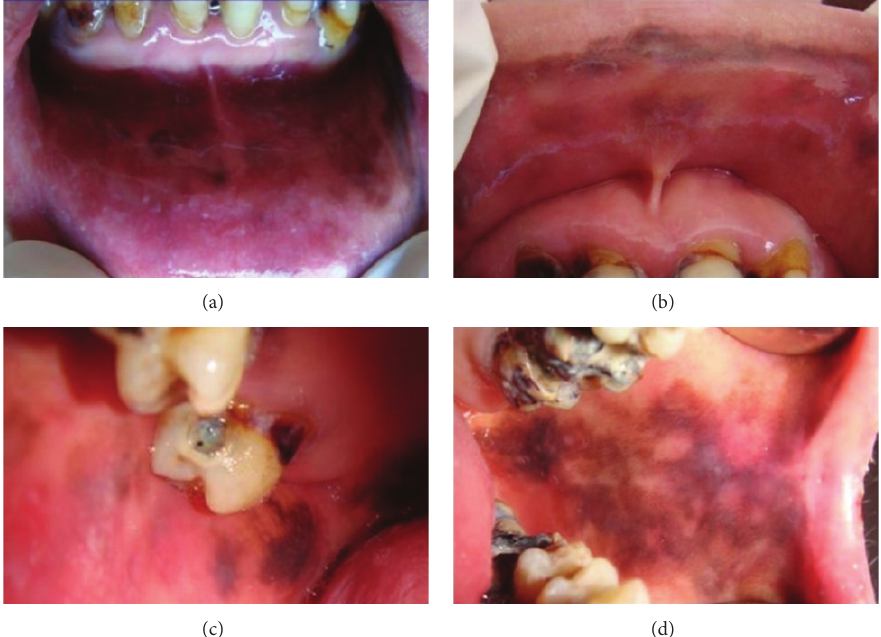
Figure 1: Multiple, painless brown-black pigmentation, on the buccal mucosa, lower lip, and posterior of the palate, bilaterally.